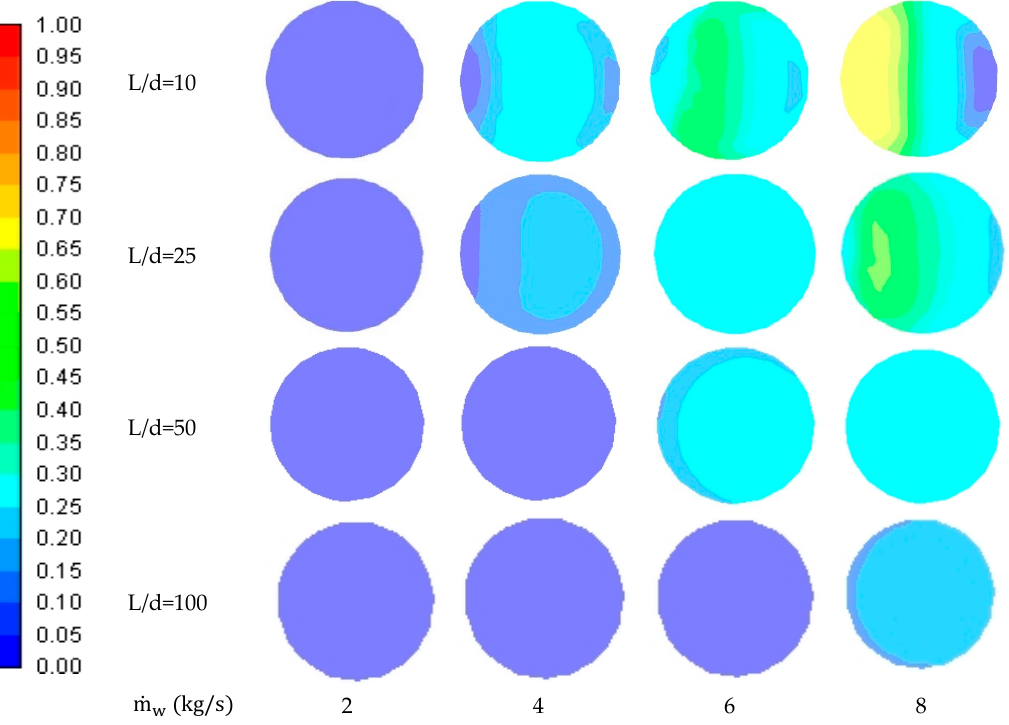
Figure 28. Radial vapor volume fraction contours at different downward distances from the side pipe centerline at various flow ratios and X (cid:2933) = 662.96, α (cid:2923) = 0.7 , X (cid:2932) = 0.5 .